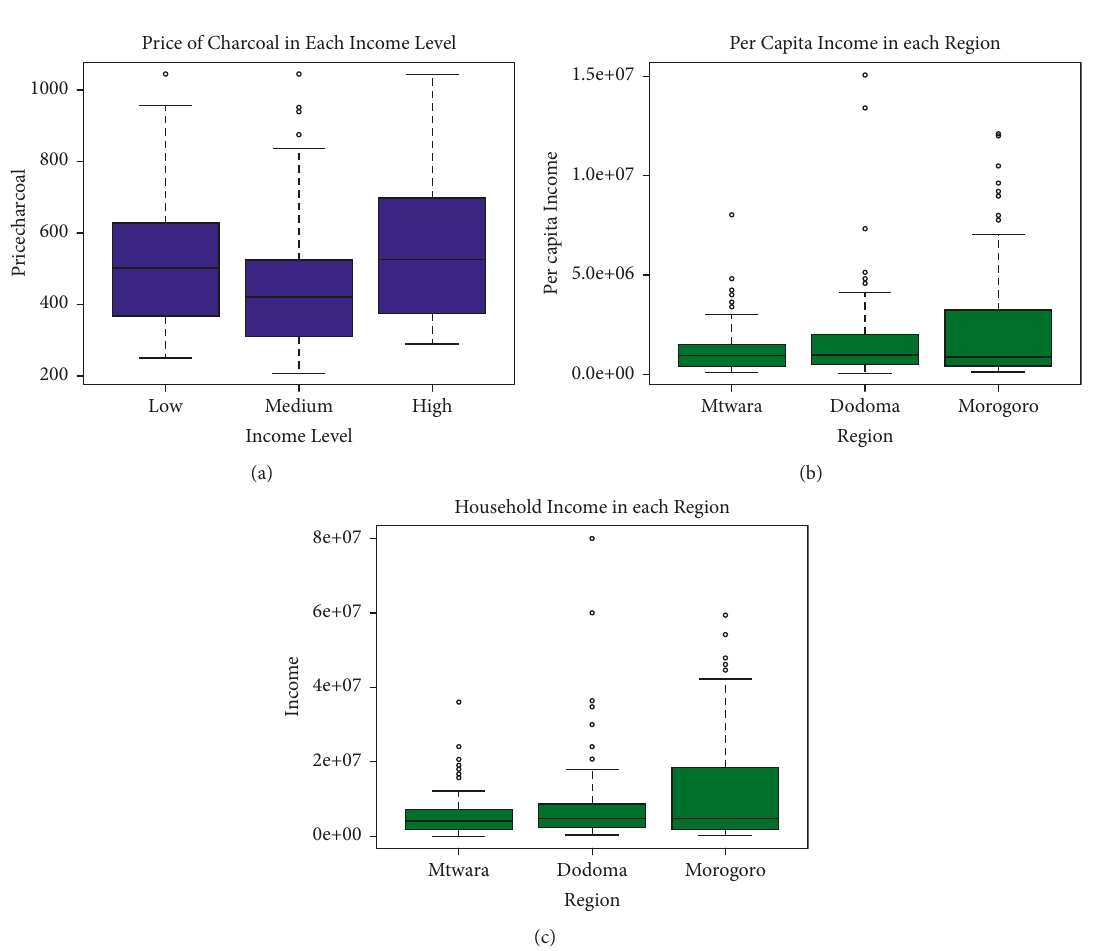
Figure 8: (a) Price of charcoal (TZS per kg) in the three income groups, (b) per capita income (TZS per year) in each of the three regions, and (c) household income (TSZ per year) in each of the three